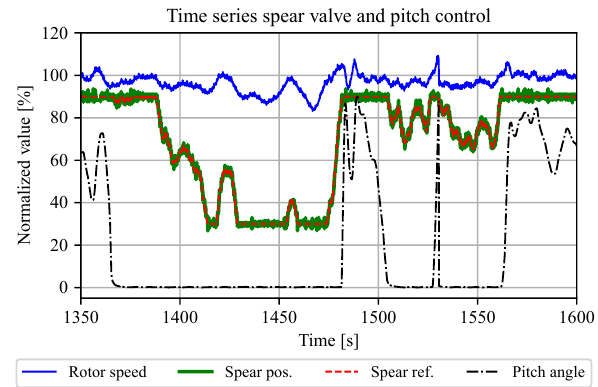
Figure 23. A time series showing the hydraulic control strategy for the DOT500 turbine. The spear valve position actively regulates the rotor speed as a substitute for conventional turbine torque control. In the above-rated region, pitch control is employed to keep the rotor at its nominal speed. All signals in this plot are